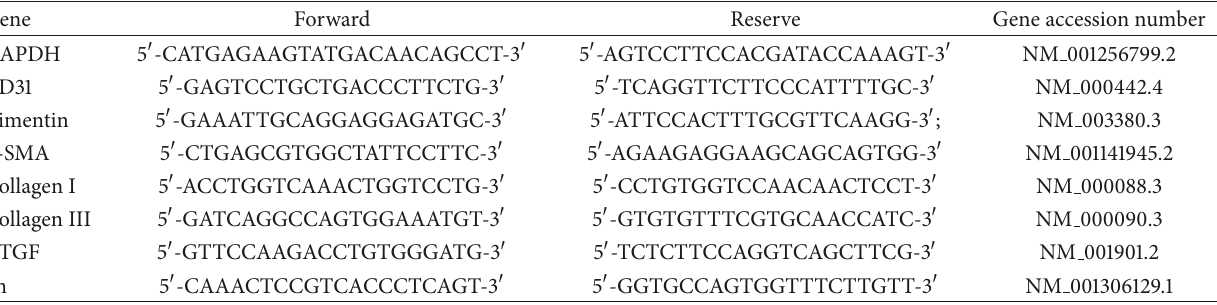
Table 1: Gene-specific primers used in quantitative real-time